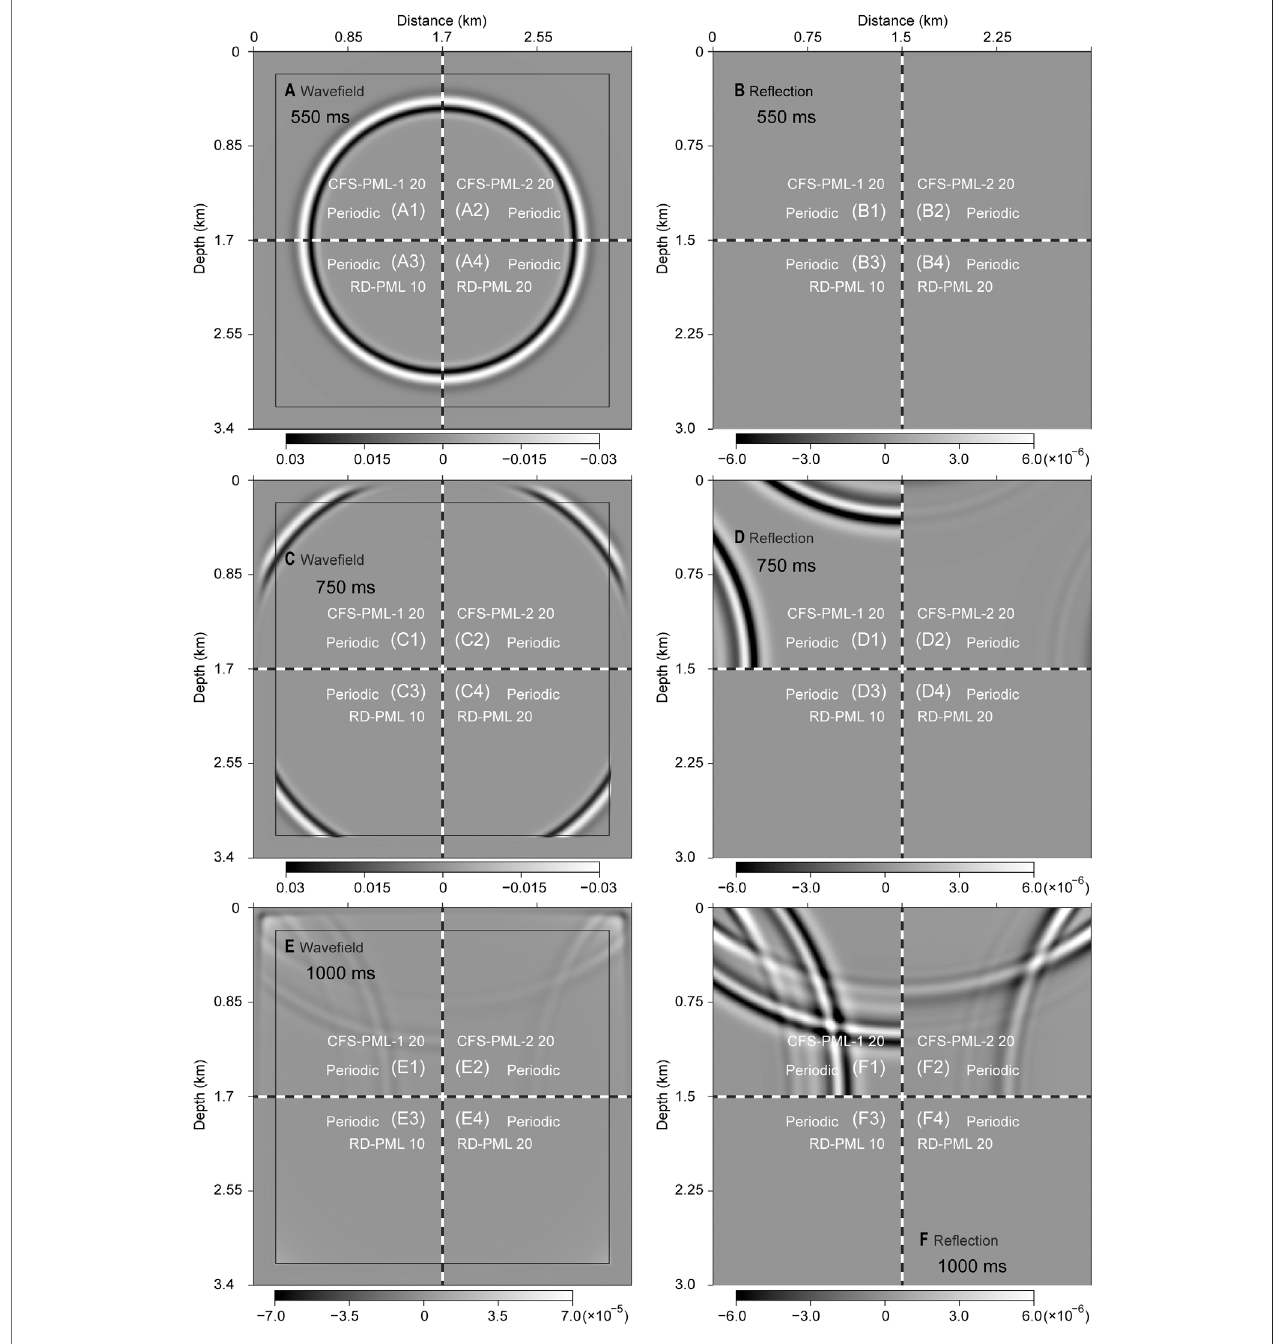
FIGURE 5 | Snapshots and wave re fl ections obtained using different types of PML using periodic boundary. (A) , (C) , and (E) are the snapshots obtained at 550, 750, and 1,000 ms, respectively. (B) , (D) , and (F) are the wave re fl ections obtained at 550, 750, and 1,000 ms, respectively.